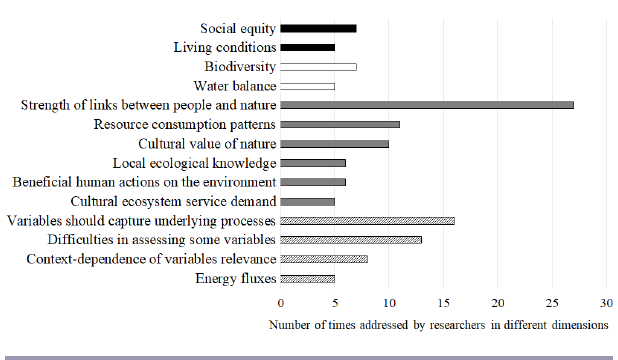
Fig. 4 . Featured topics (addressed by five or more respondents in different dimensions) related to potential biases and gaps in the list of variables identified from comments and suggestions in the final survey. Black, white, and gray bars represent the social system, ecological system, and interaction components, respectively, while striped bars reflect issues that are transversal to the whole conceptual framework. (See also these topics in the conceptual map of Appendix